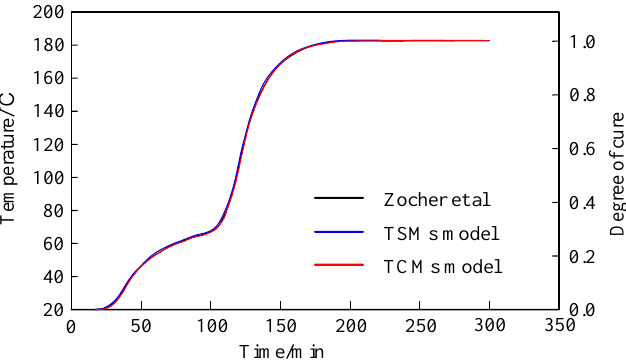
Figure 3. Comparison of the changes of (0,0,0) curing degree.